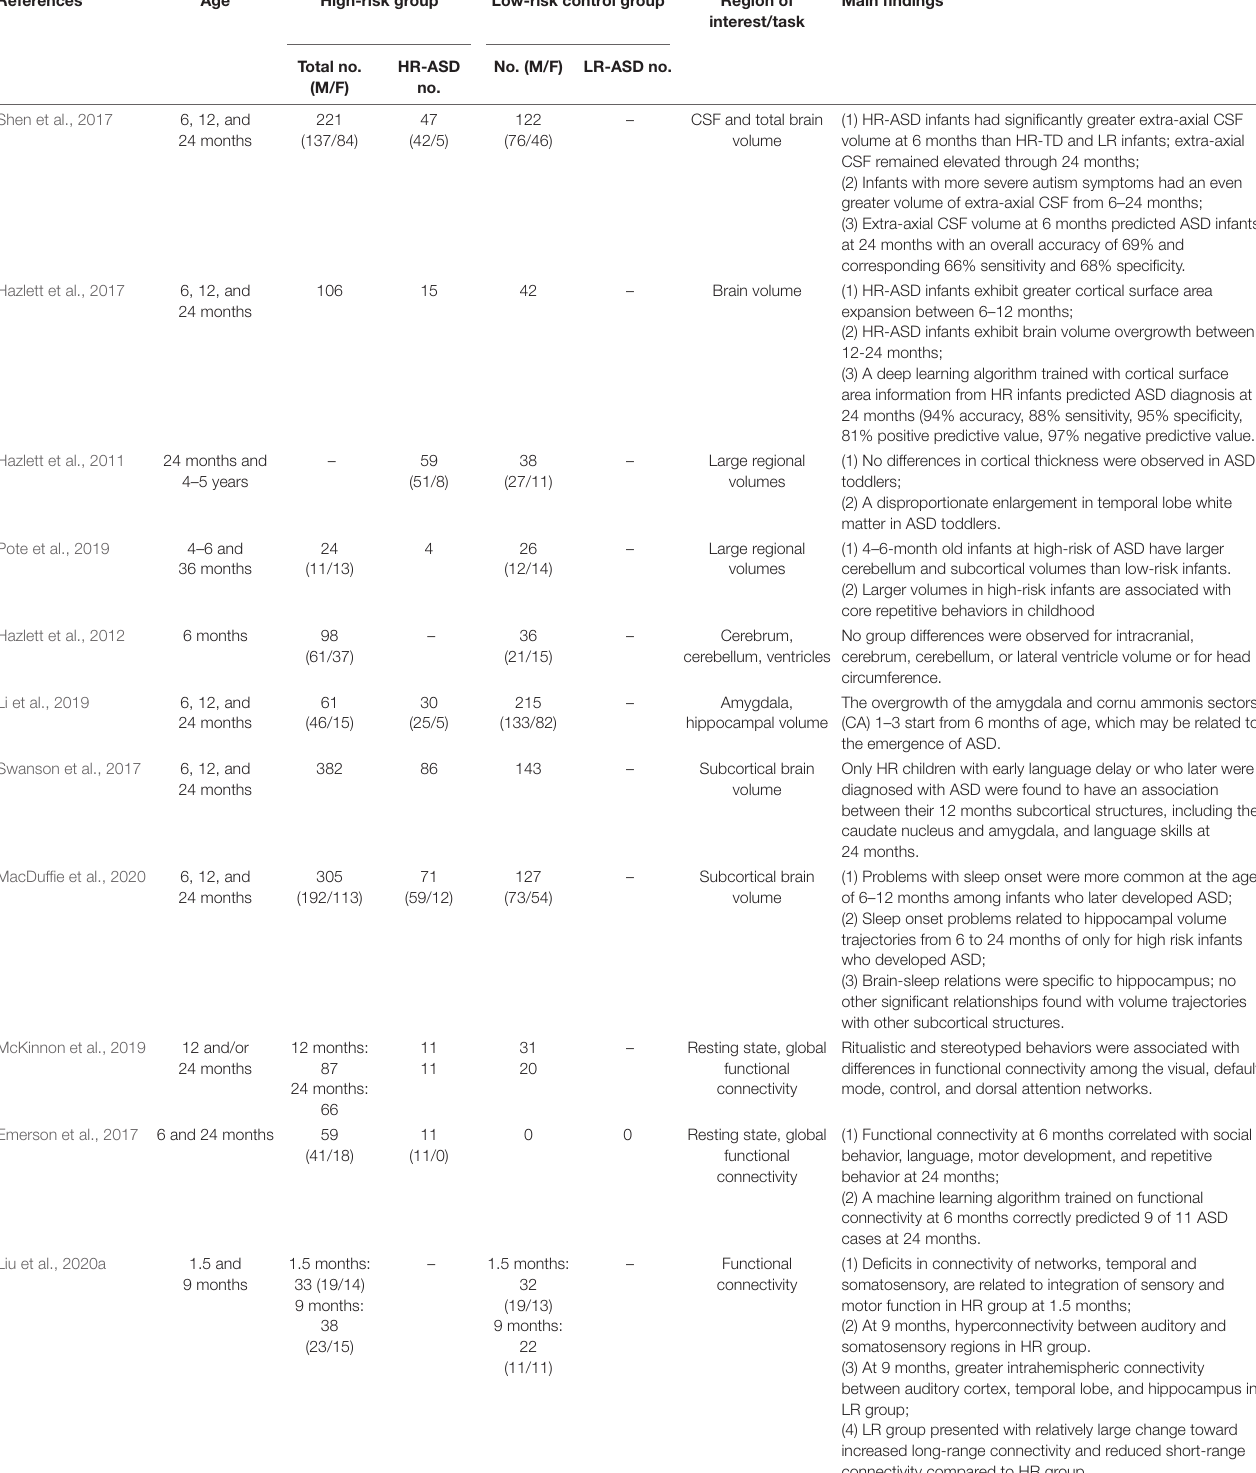
(1) HR-ASD infants had significantly greater extra-axial CSF volume at 6 months than HR-TD and LR infants; extra-axial CSF remained elevated through 24 months; (2) Infants with more severe autism symptoms had an even greater volume of extra-axial CSF from 6–24 months; (3) Extra-axial CSF volume at 6 months predicted ASD infants at 24 months with an overall accuracy of 69% and corresponding 66% sensitivity and 68% specificity.